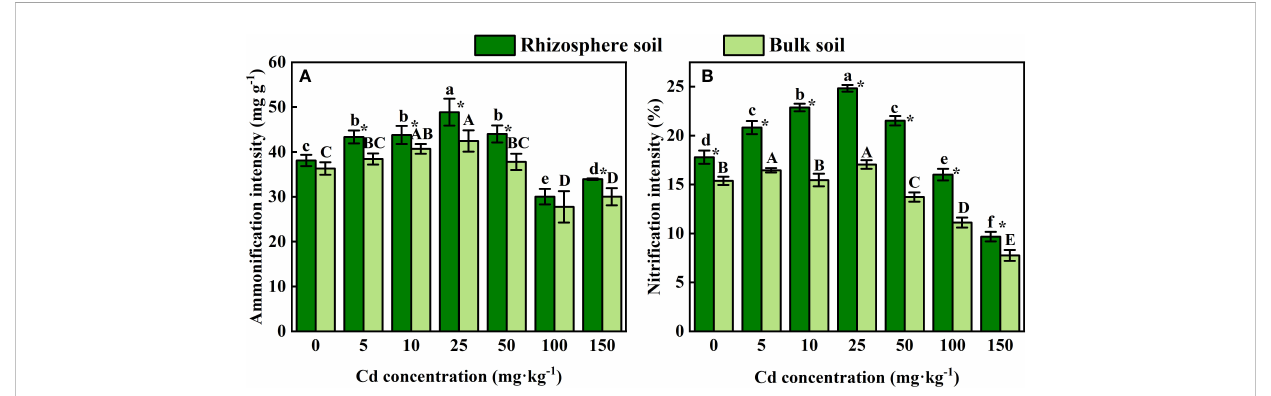
FIGURE 5 Error bar represents standard deviation (n=3). * indicate signi fi cant difference at P < 0.05 level in the same treatment between rhizosphere and bulk soil, different lower case letter (upper case letter) at the column indicate signi fi cant difference at P < 0.05 level in the rhizosphere soil (in the bulk soil) according to ANOVA and Duncan tests, the same as follows.